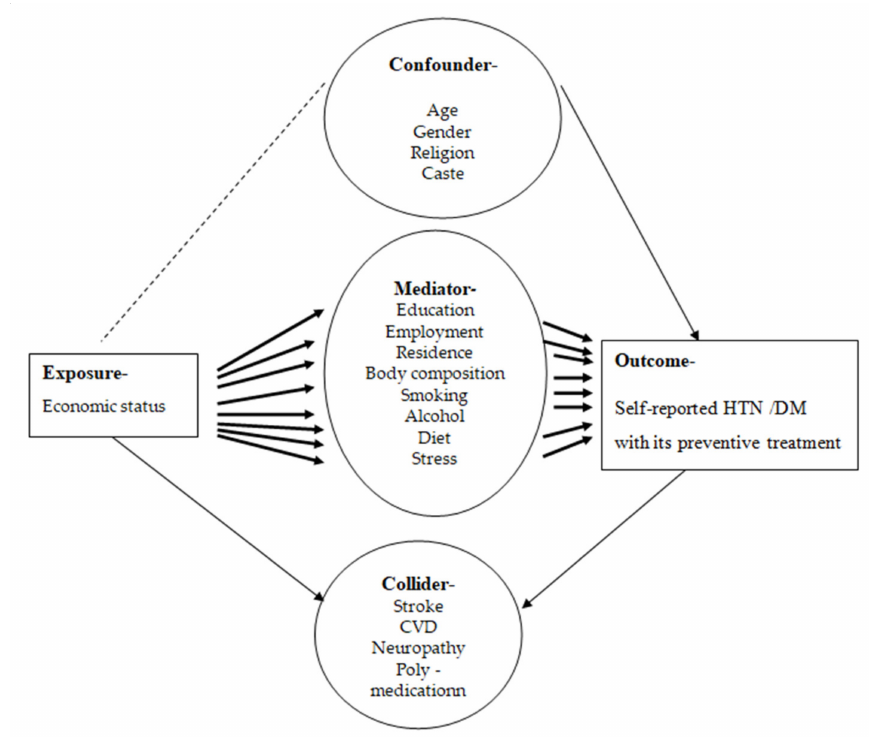
Figure 2. Simplified direct acyclic graph exhibiting the hypothesized causal association between economic status and self-reported HTN/DM and its preventative